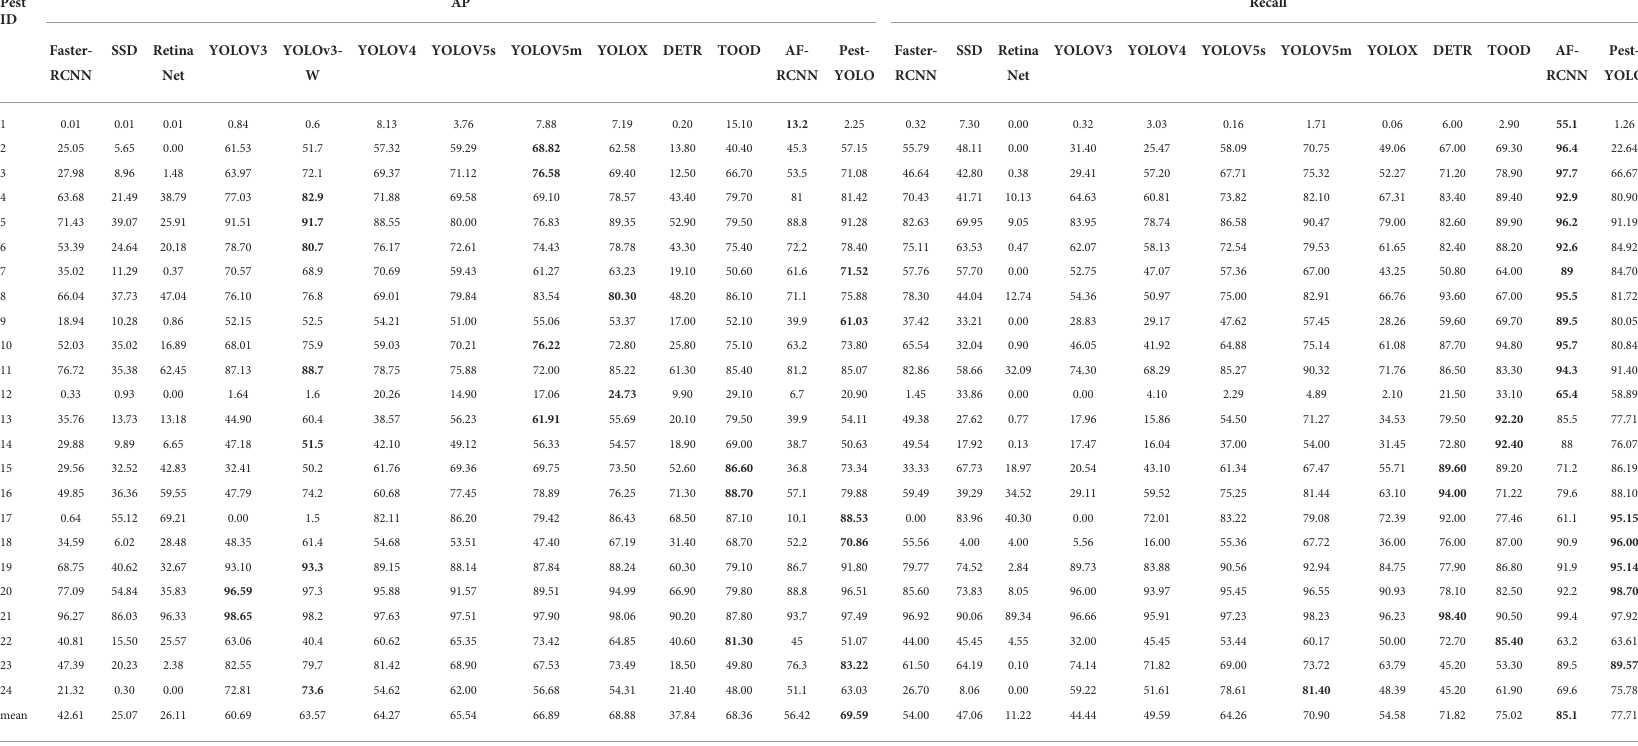
TABLE 7 Comparison results of the pest categories (unit: %). Pest